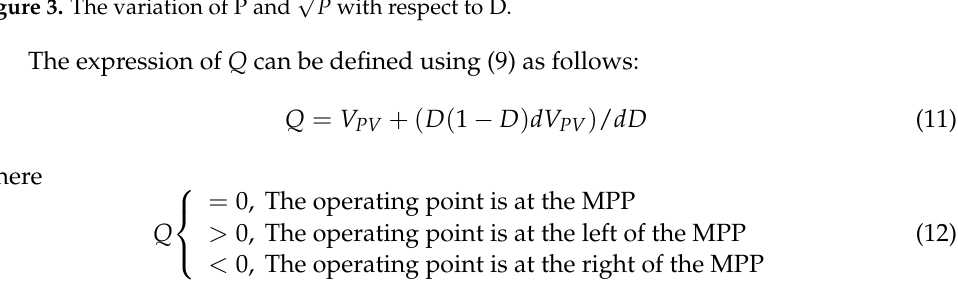
Figure 3. The variation of P and √𝑃 with respect to D .